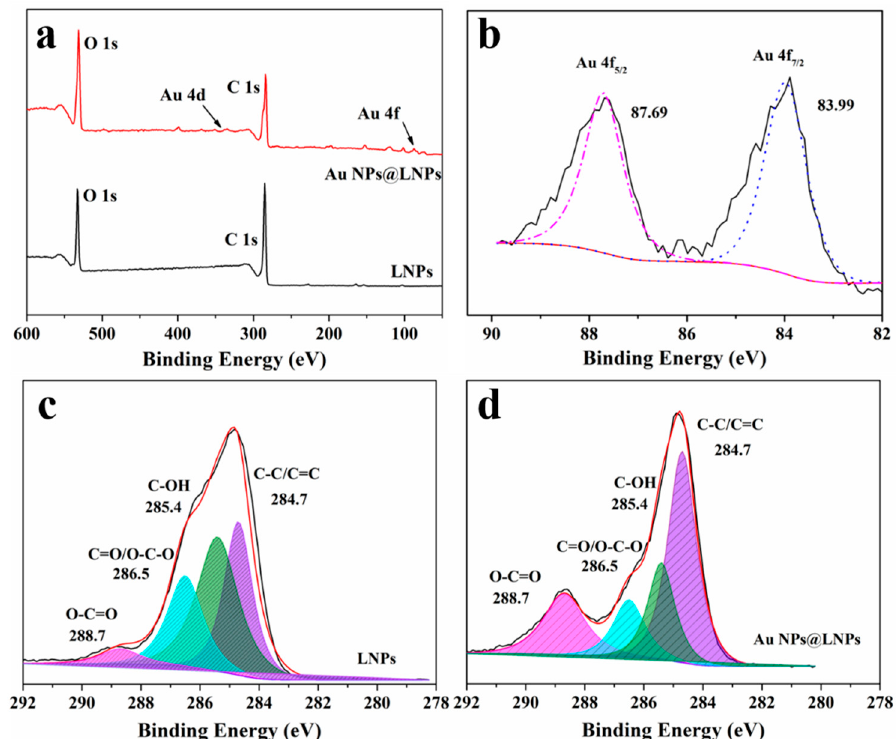
Figure 8. ( a ) XPS of the wide scan of LNPs and Au NPs@ LNPs. ( b ) Au 4f of the Au NPs@ LNPs ( c ) C 1s of the LNPs, ( d ) C 1s of the Au NPs@ LNPs. 1s of The LNPs, ( d ) C 1s of The Au NPs@